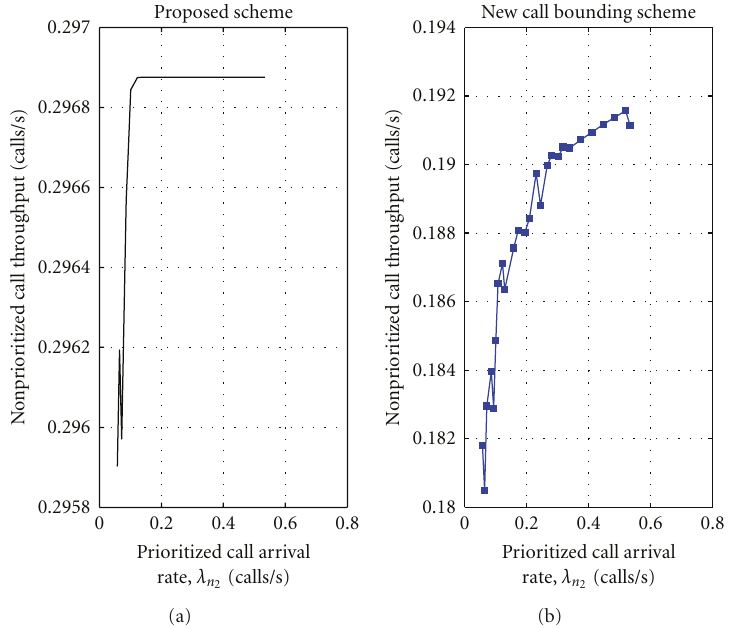
Figure 6: Throughput versus prioritized calls arrival rate.